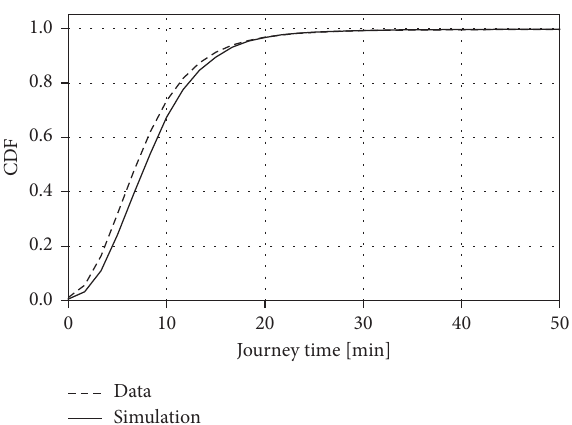
Figure 2: Comparison of journey times in simulation and in the original data set for San Francisco taxi